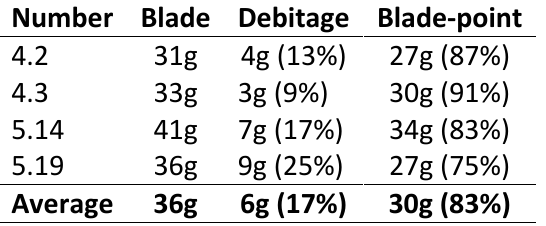
Table 2. Summary of original blade weight and percentage of material removed in relation to the resultant blade- point